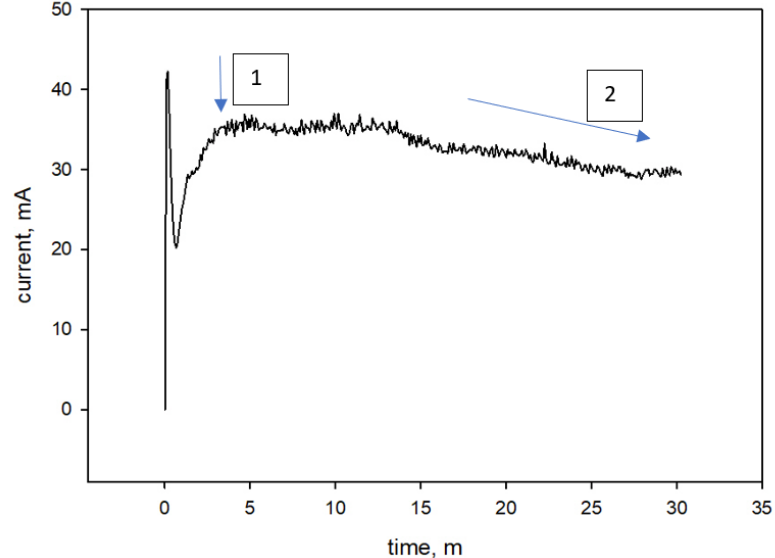
Figure 3. Current vs. time current profile obtained during the anodization procedure. The barrier oxide layer formation is highlighted by the arrow n. 1, whereas the point whereby the current starts to gradually diminish due to the growth of the oxide layer nanostructure is indicated by the arrow n.